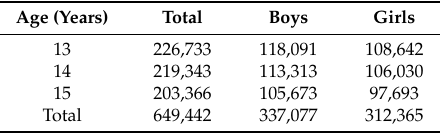
Table 1. Demographics of study participants.